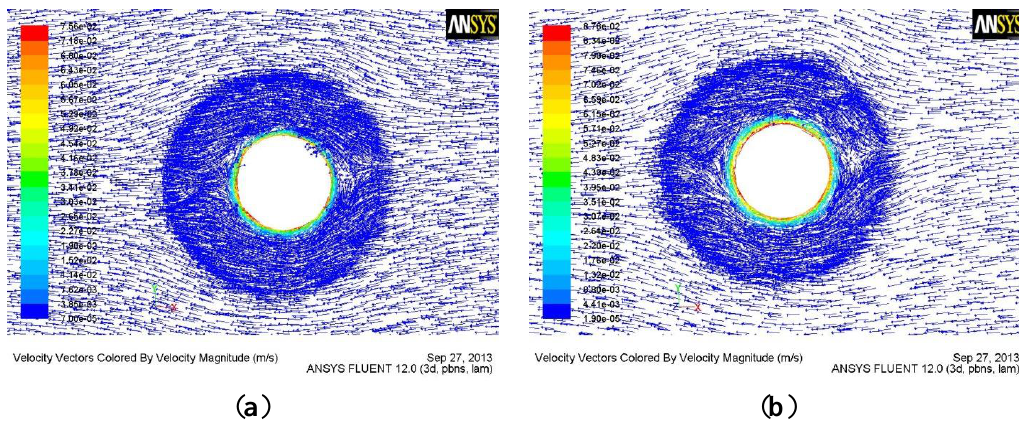
Figure 6. ( a ) Flow field at section b by conventional tool; ( b ) Flow field at section b by the tool with the half-screw pin.